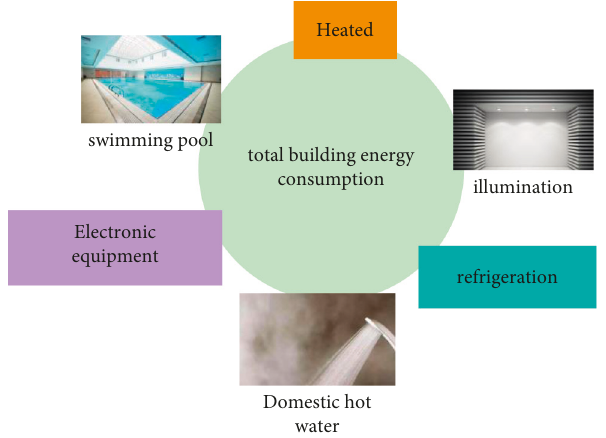
Figure 1: Overall composition of building energy